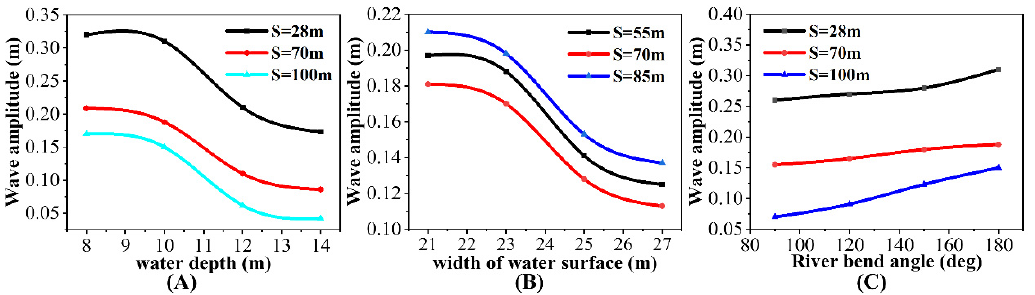
Figure 12. Variation in wave amplitude with water depth, width of water surface and river bending angle: ( A ) water depth; ( B ) water surface width; ( C ) river bending angle.